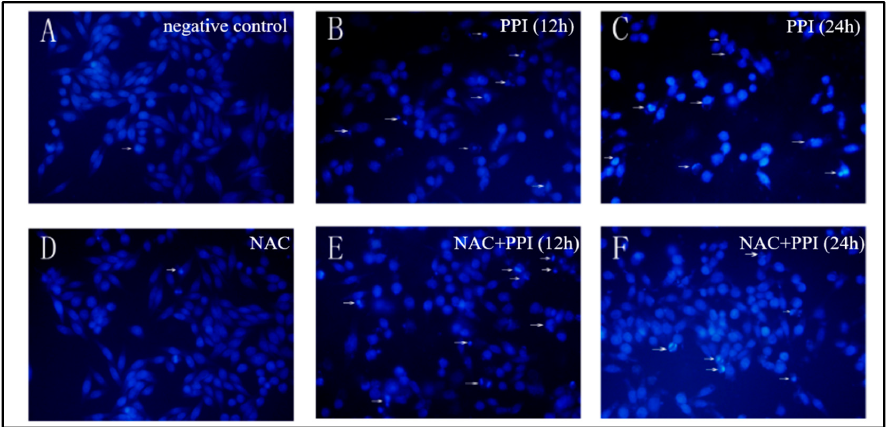
Figure 9. The changes in nuclear morphology were tested by DAPI staining after treatment with NAC (1000 × ). Note: ( A ): negative control group; ( B ): treated with 5 µ mol/L PPI for 12 h; ( C ): treated with 3.5 µ mol/L PPI for 24 h; ( D ): only treated with NAC; ( E ): treated with NAC and 5 µ mol/L PPI for 12 h; ( F ): treated with NAC and 3.5 µ mol/L PPI for 24 h. Arrows indicate the apoptotic